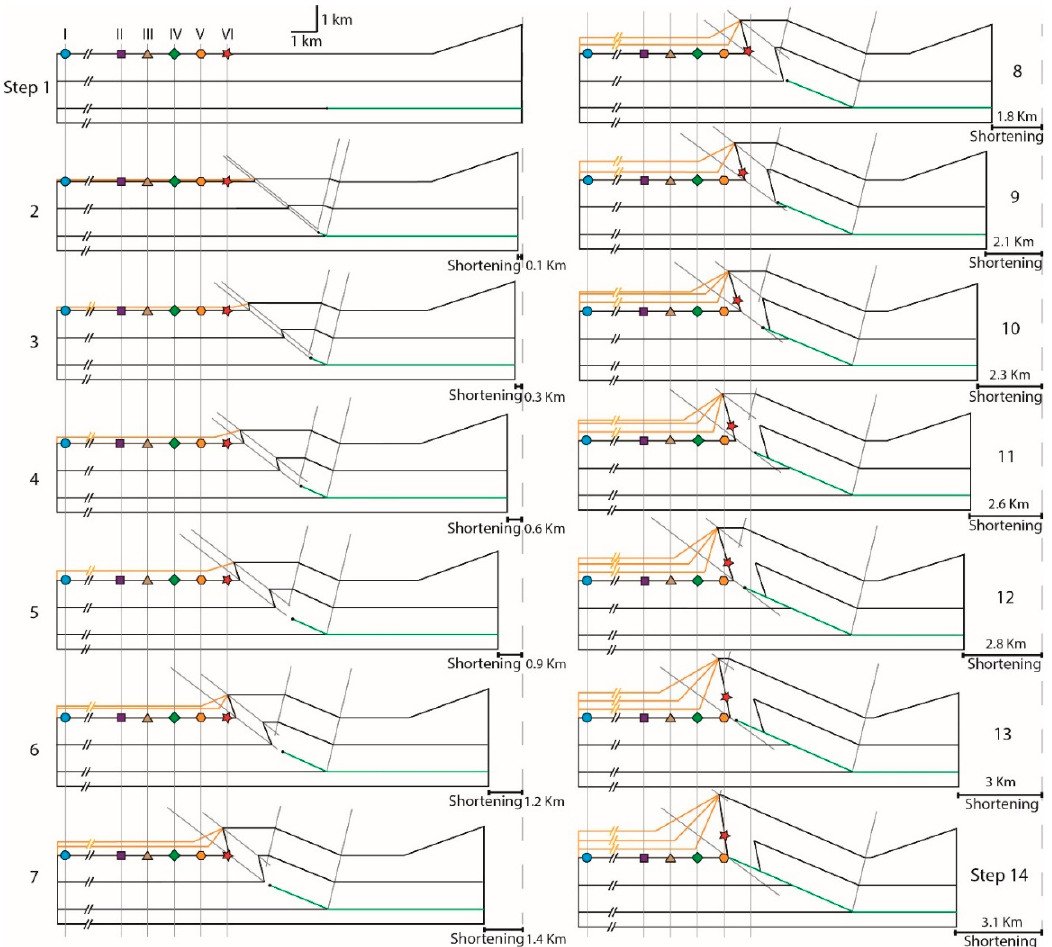
Figure 3. Schematic representation of the fold evolution geometry for each step and localization of the different key points used for the local stress estimations represented by the markers.